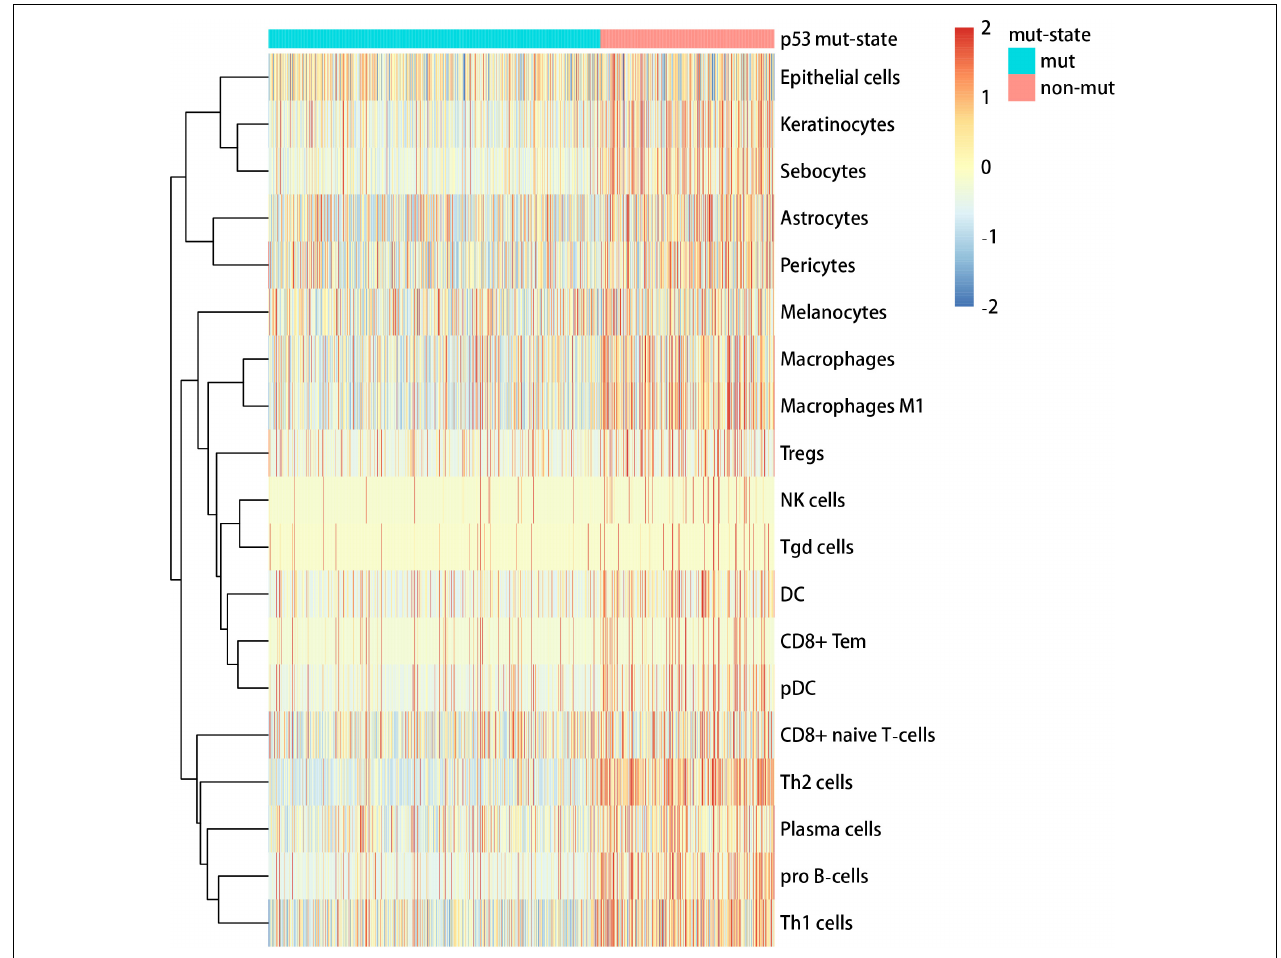
FIGURE 4 | Heat map of cell abundance between TP53 mutation and non-mutation